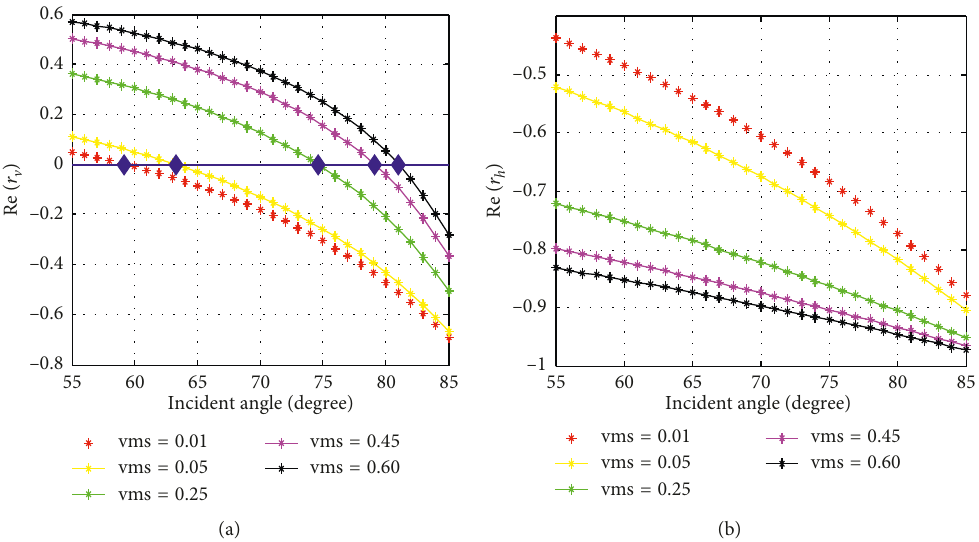
Figure 2: Real parts of the Fresnel reflectivity vs. the incident angles: (a) Re [ r